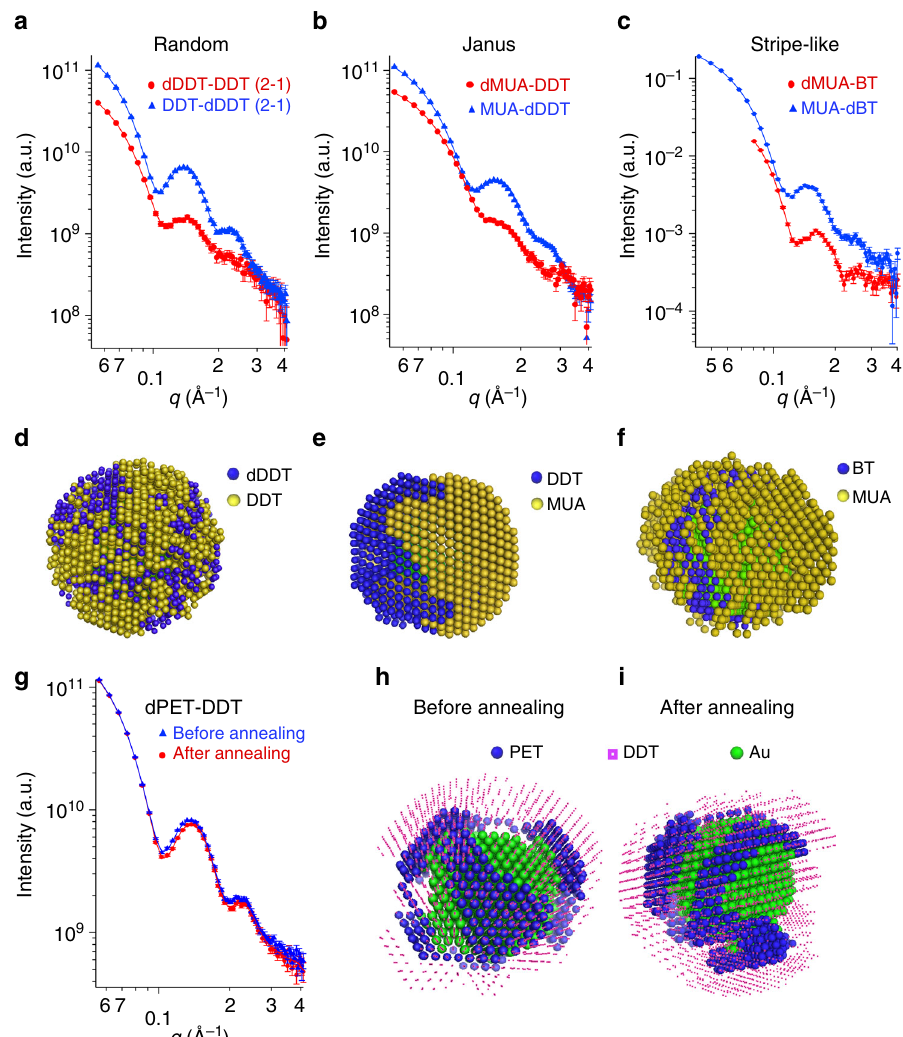
Fig. 2 SANS data and 3D models for nanoparticles with different morphologies. SANS data and fi ts for dDDT-DDT ( a ), MUA-DDT ( b ), and MUA-BT ( c ) nanoparticles. For the fi rst nanoparticle, the SANS data of dDDT-DDT are in blue and of DDT-dDDT are in red. While for the last two samples, the SANS curve is in red when MUA is deuterated and in blue when the other ligand is deuterated. The corresponding 3D models are presented in d – f . g SANS data and fi ts for dPET-DDT nanoparticle before (blue) and after (red) annealing. The corresponding models are shown in h and i , with PET beads in blue and DDT beads in pink for clarity. The error bars in the SANS data represent standard deviations of neutron counts and are explained in detail in Method